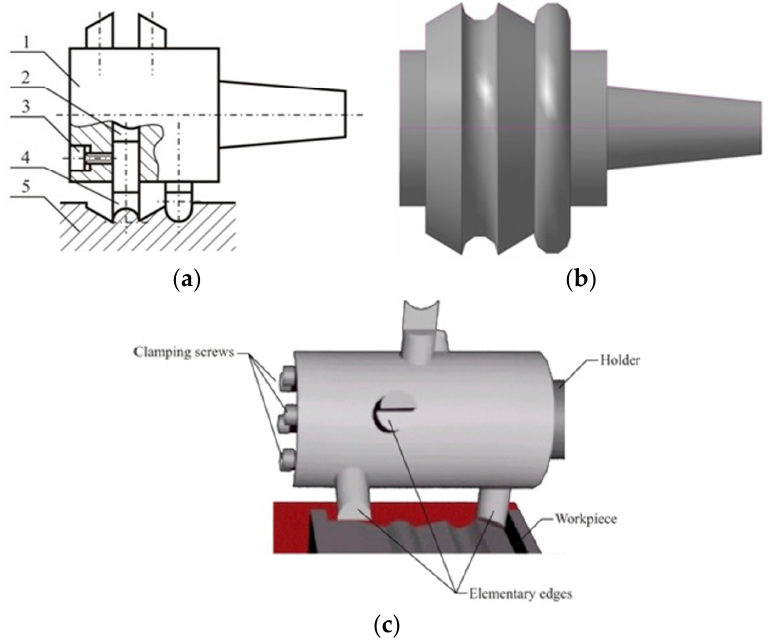
Figure 5. Universal profile cutter with single inserts: ( a ) a sketch of the cutter [43], ( b ) an example of multi-insert configuration, and ( c ) virtual model of profile cutter in contact with the machined surface.